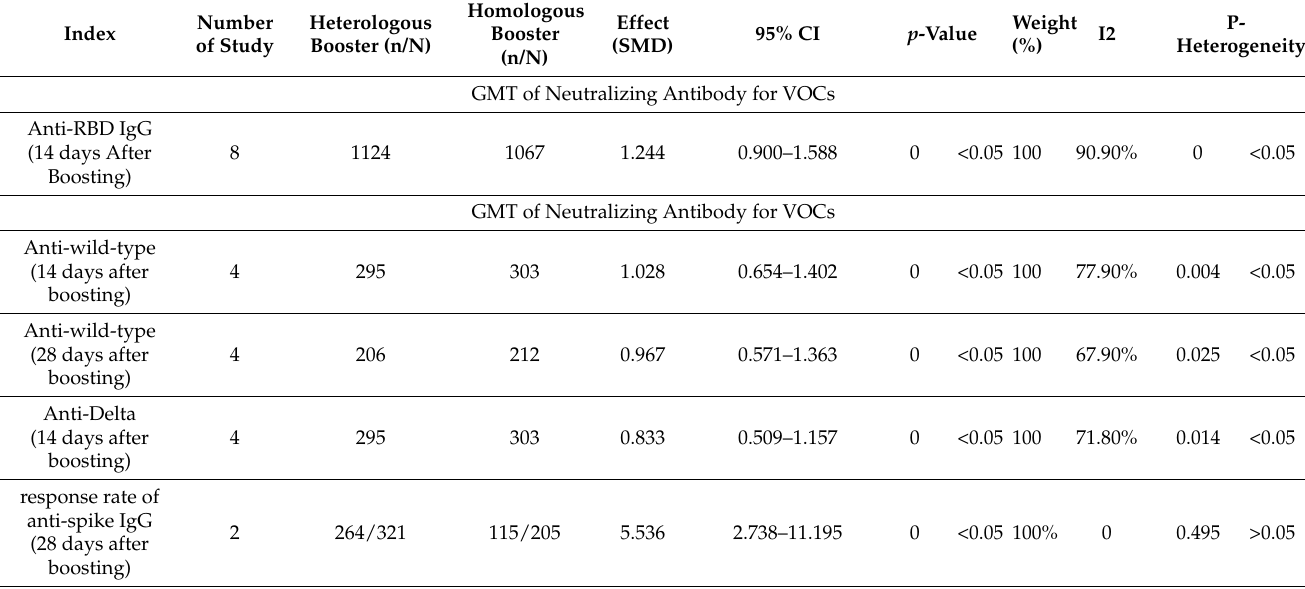
Table 2. Comparison of immunogenicity between heterologous booster and homologous